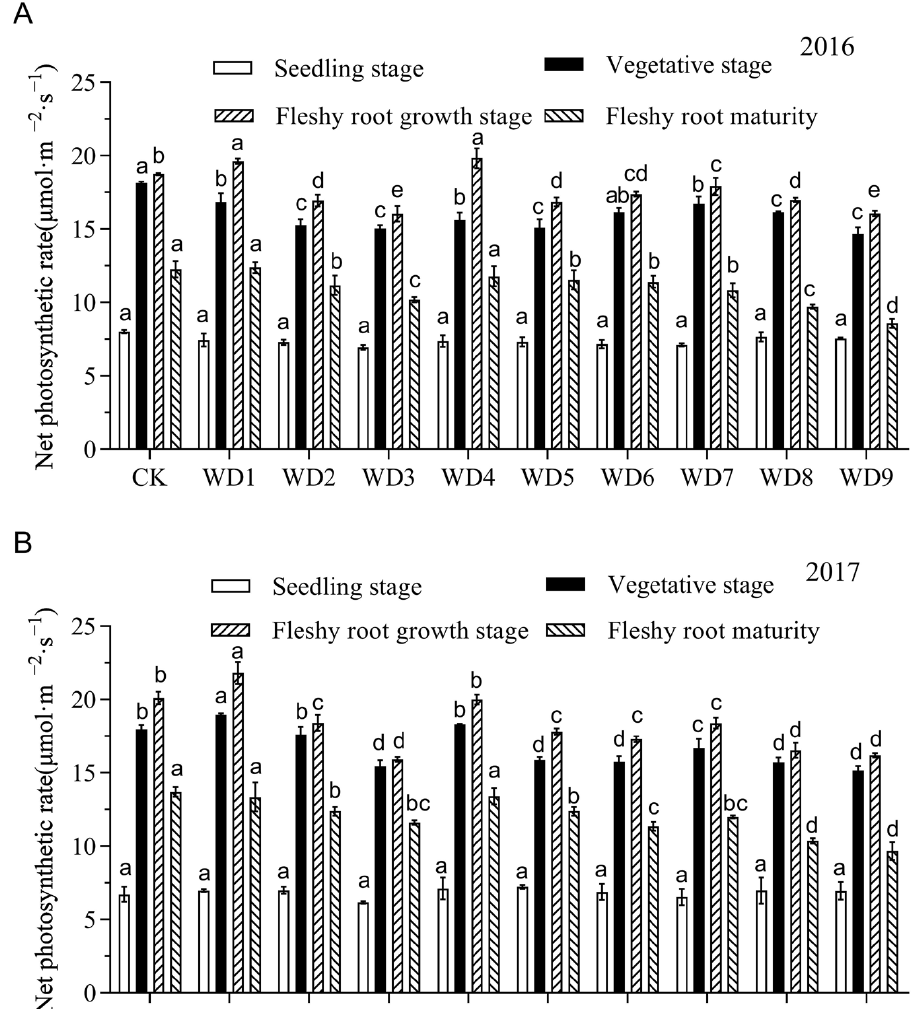
Figure 2. Net photosynthetic rates under various water treatments across the 2016 and 2017 cropping seasons. Different lowercase letters within a column indicate a significant difference among treatments at p < 0.05. ( A ) The experimental data in 2016. ( B ) The experimental data in 2017. WD1: mild water deficit in the vegetative stage, WD2: moderate water deficit in the vegetative stage, WD3: severe water deficit in the vegetative stage, WD4: mild water deficit in the vegetative stage and fleshy root growth stage, WD5: mild water deficit in the vegetative stage and moderate water deficit in the fleshy root growth stage, WD6: moderate water deficit in the vegetative stage and mild water deficit in the fleshy root growth stage, WD7: moderate water deficit in the vegetative and fleshy root growth stage, WD8: severe water deficit in the vegetative and mild water deficit in the fleshy root growth stage, WD9: severe water deficit in the vegetative and moderate water deficit in the fleshy root growth stage, CK: normal water supply in all growth